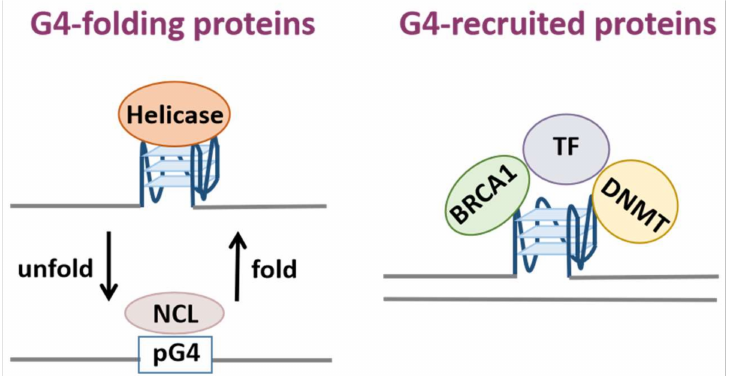
Figure 1. Classification of G-quadruplex-binding proteins. G4BPs can be classified into two categories: G4-folding proteins which can fold or unfold G4s such as nucleolin (NCL) and helicases and G4- recruited proteins which can be recruited by G4 such as transcription factors (TF), DNA repair proteins (BRAC1) and chromatin remodeling proteins (DNA methyltransferase,